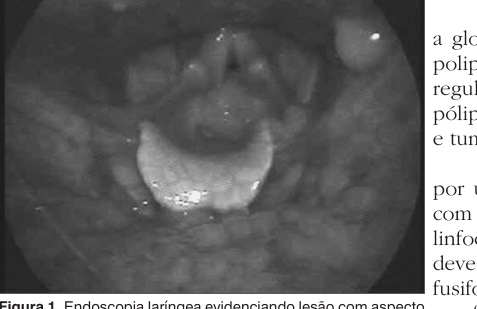
Figura 1. Endoscopia laríngea evidenciando lesão com aspecto granulomatoso ocupando quase toda